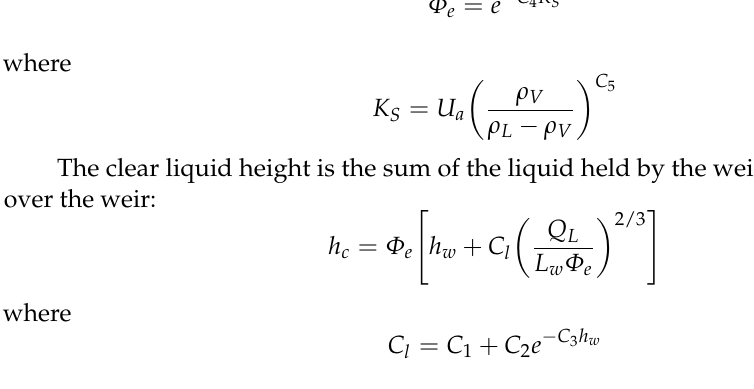
Table A1. Froth density and clear liquid height model coefficients